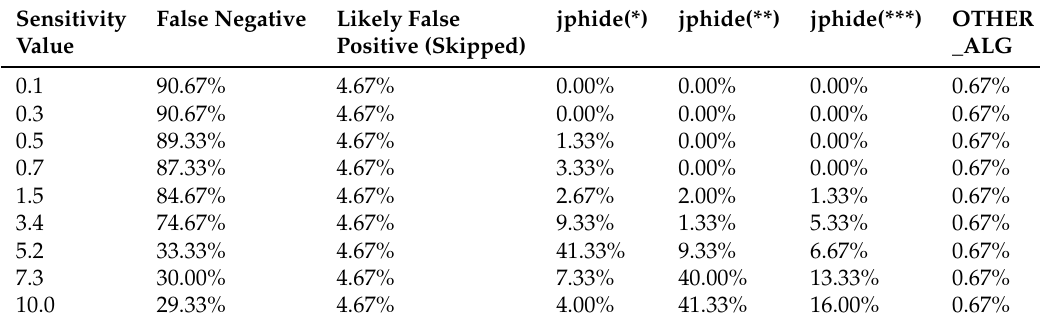
Table 6. Results of 150 images from google image database (SAFE OFF) with different sensitivity values. Sensitivity False Negative Likely False jphide(*)